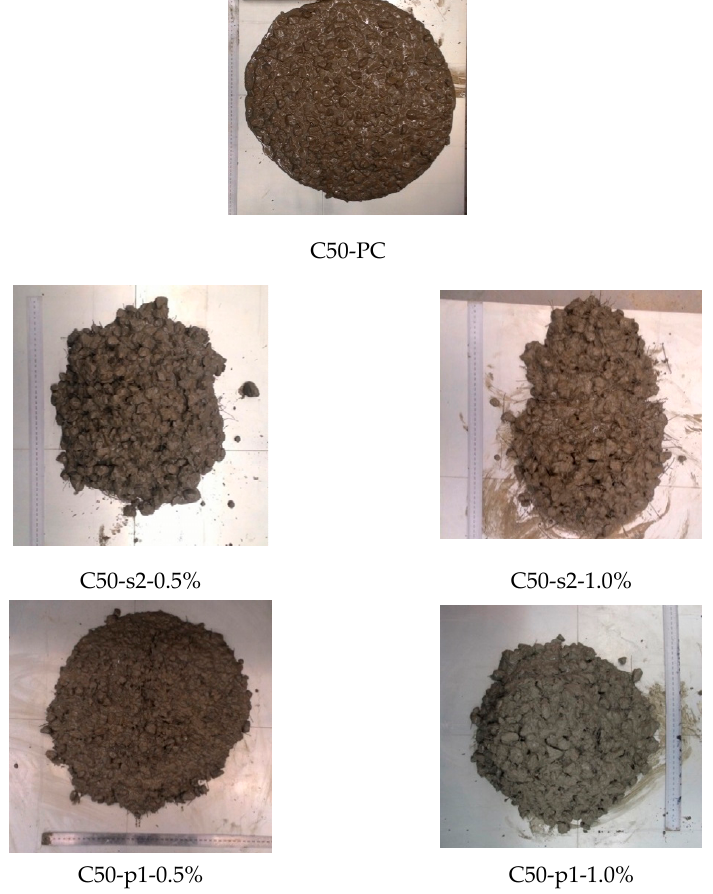
Figure 5. DIN flow table test of concrete C50 reinforced by fibers s2 and p1. Table 5. ρ ratio for PC and FRC with different fiber types.